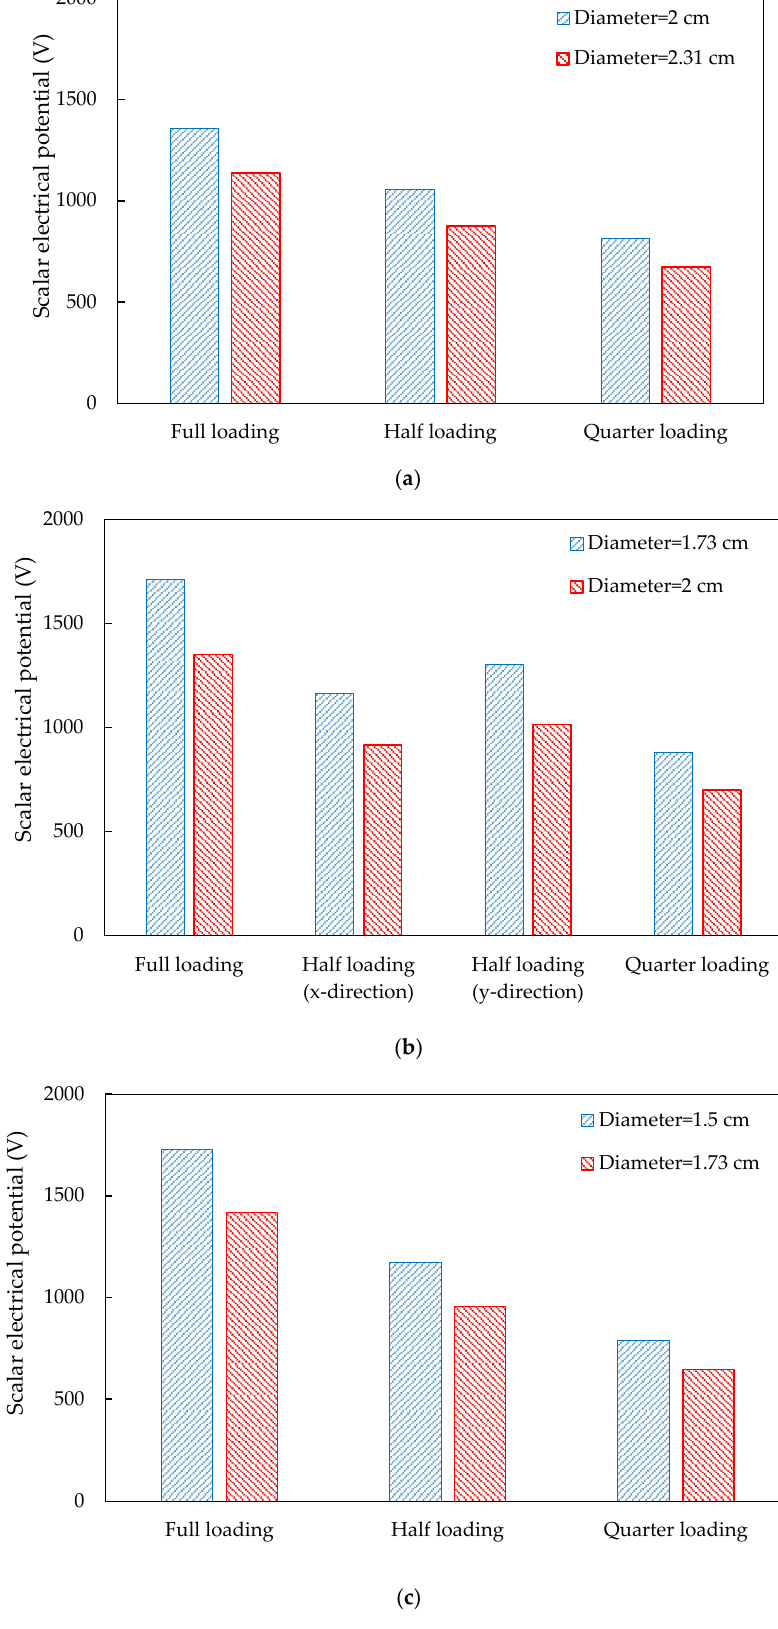
Figure 13. Electrical potential in the PEHs with different piezoelectric unit distributions: ( a ) 3 × 3; ( b ) 3 × 4; ( c ) 4 × 4.